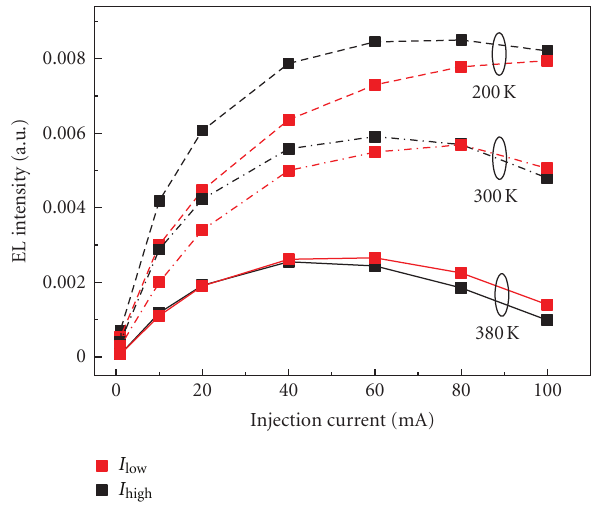
Figure 6: Driving current-dependent EL intensity of emissions from higher energy ( I high ) and lower energy ( I low ) at temperature 200, 300, and 380 K, respectively.